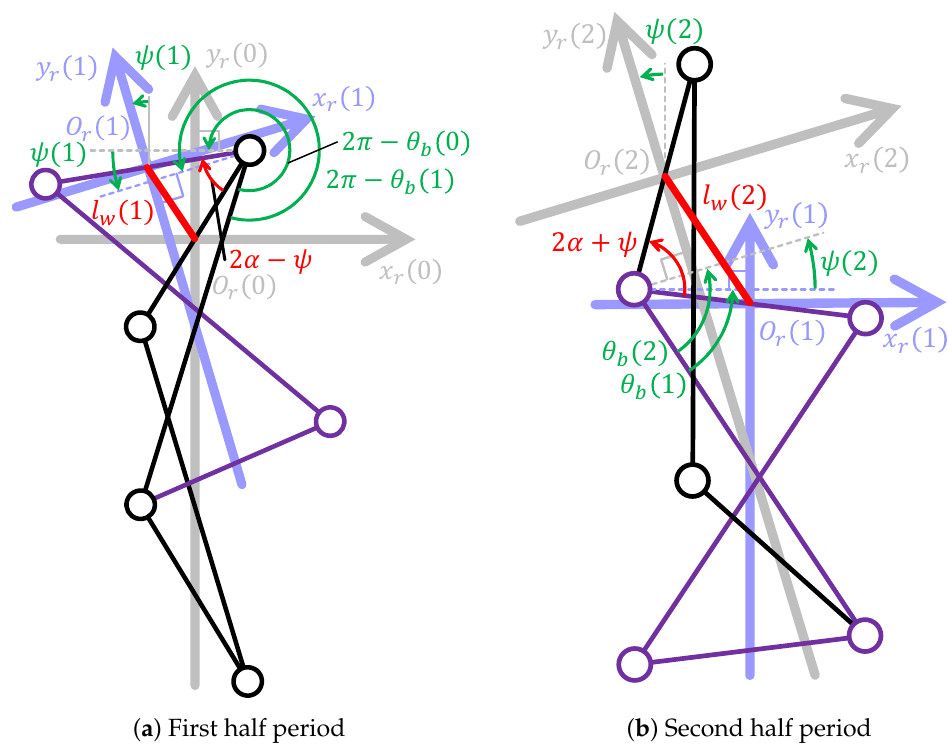
Figure 4. Variations of the robot’s posture. ( a ) First half period. ( b ) Second half period. The black line with a gray axis shows both the initial posture and the posture after one period of the robot, and the purple line with a pale purple shows the posture after half of a period of the robot. Meanwhile, the green arrows define the angles of each state, and the red lines show the stride length of the robot and an angle for realizing the stride. It is shown that ψ ( i ) equals the difference between θ b ( i ) and θ b ( i − 1 ) . In addition, it is shown that the relationships between P 1 , O r ( 0 ) , and O r ( 1 ) and P 2 , O r ( 1 ) , and O r ( 2 ) configure isosceles